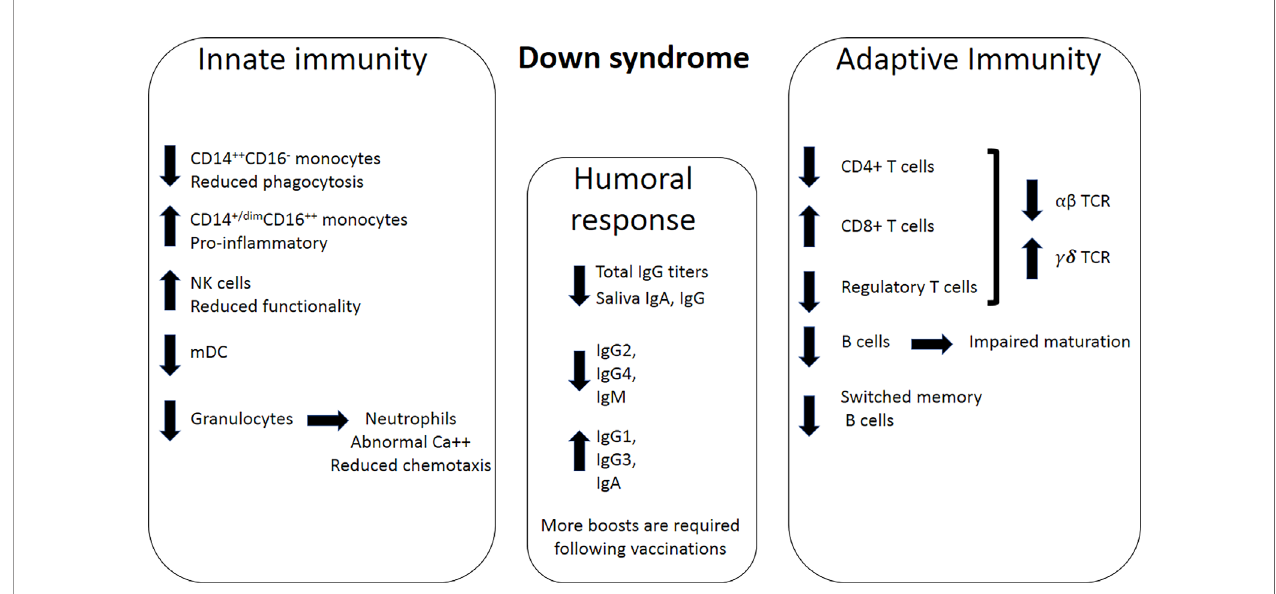
FIGURE 3 | Immune dysregulation in DS. Left panel; Innate immunity impairments in DS include a decrease in CD14 ++ CD16 - monocytes, an increase in CD14 + CD16 + monocytes, increase in NK cells, a decrease in myeloid dendritic cells (mDC), and a decrease in granulocytes. Neutrophils exhibit dysregulated Ca ++ homeostasis and reduced chemotactic ability, which results in impaired functionality. Middle panel; humoral response dysregulation includes a decrease in total IgG, as well as IgG and IgA levels in the saliva. Speci fi cally, of IgG2, IgG4, and IgM production levels decrease, while production levels of IgG1, IgG3 and IgA increase. Right panel; Adaptive immunity impairments include a decrease in the numbers of CD4 + T cells, an increase in the numbers of CD8 + cells, and a decrease in the number of T regulatory cells. Overall, fewer T cells in DS express the ab subunits of the T-cell receptor (TCR), and more T cells express the g d subunits of the TCR. The numbers of B cells and switched memory B cells also decrease in